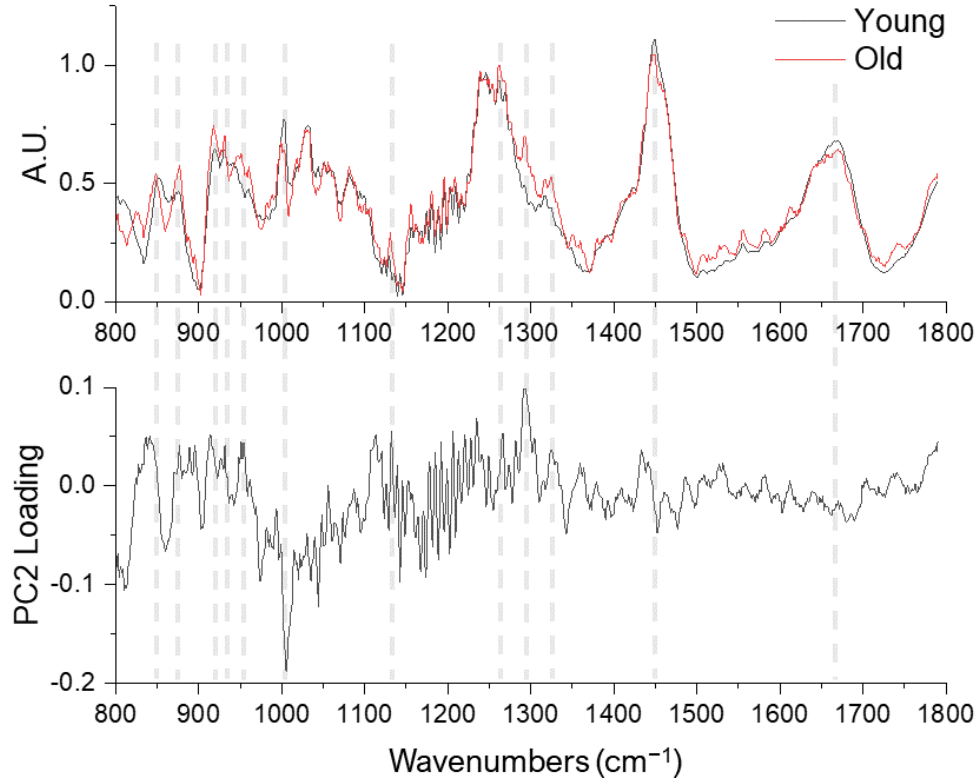
Figure 3. Averaged Raman spectra of young (n = 80, black lines) and old (n = 80, red lines) tendons (upper row) and the PC2 loading (lower row).